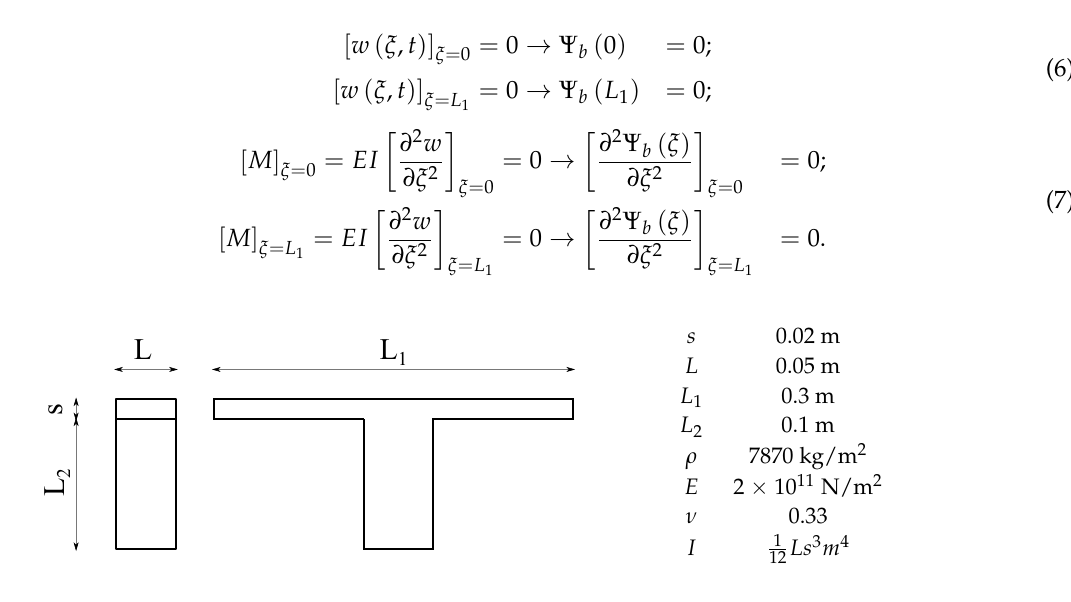
Figure 3. Properties for the continuous